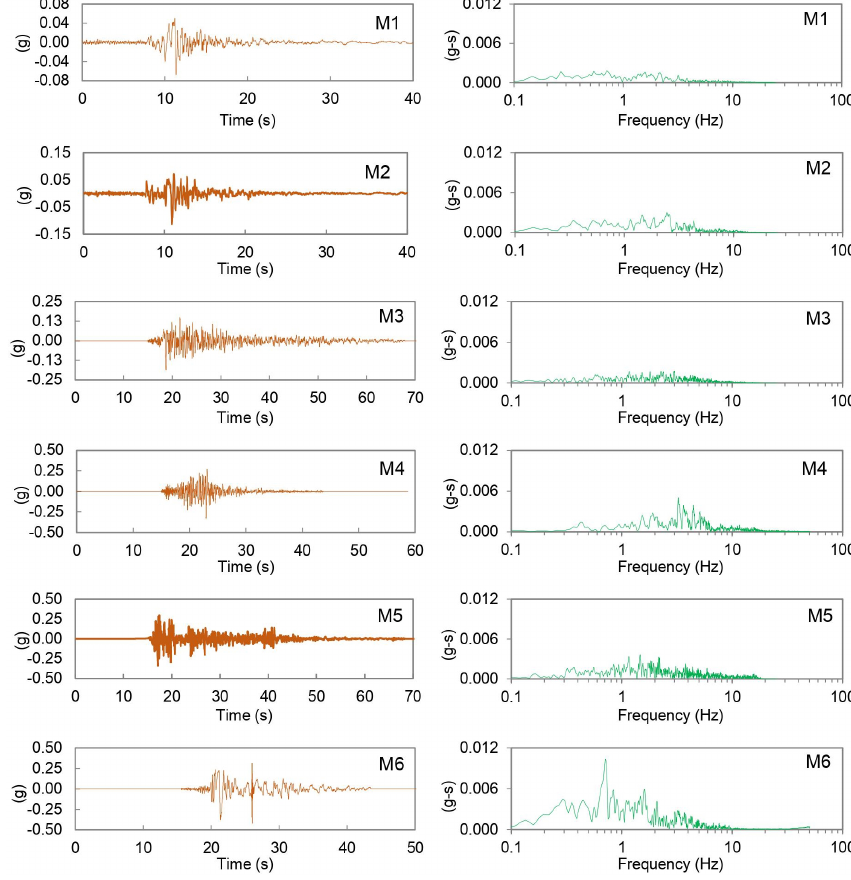
Figure 6. Strong motions and corresponding Fourier amplitude plots of the input ground